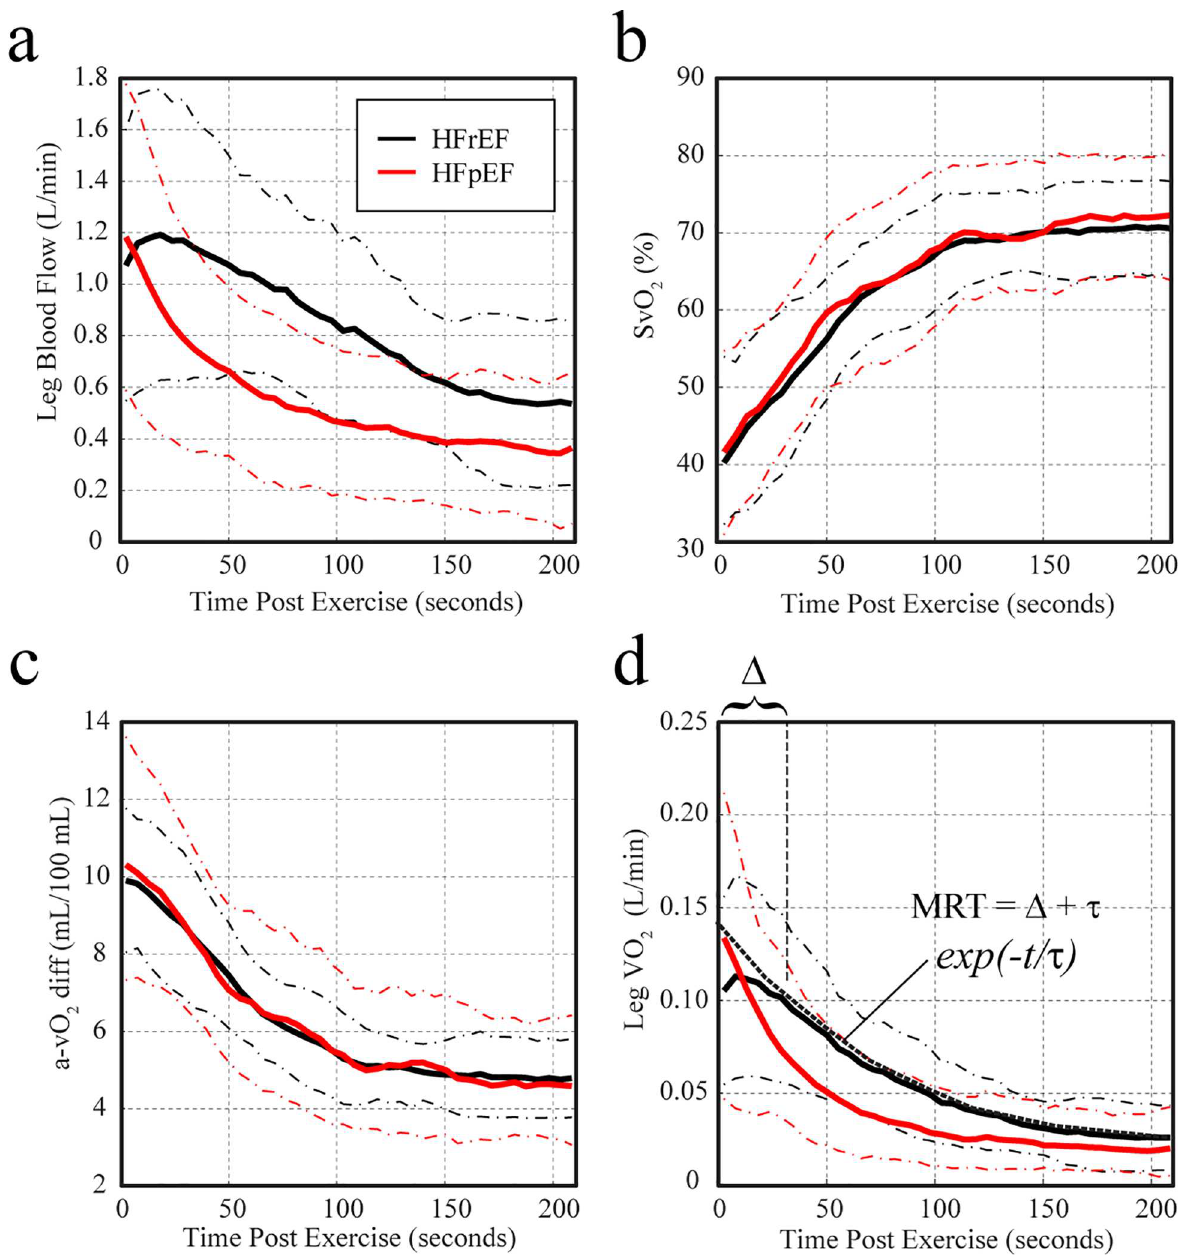
Fig 3. Group average recoverykinetics for blood flow and oxygen extraction and consumption. Average time course data for femoral vein blood flow ( a ), femoral venous oxygen saturation ( b ), a-v O 2 diff ( c ) and muscle VO 2 ( d ) are shown for HFrEF (black) and HFpEF (red) groups. The dashedlines show one standard deviationaround the mean. The mean response time (MRT) for each curve is defined as the sum of the best-fit exponentialrecovery plus the delay to the onset of exponential recovery.